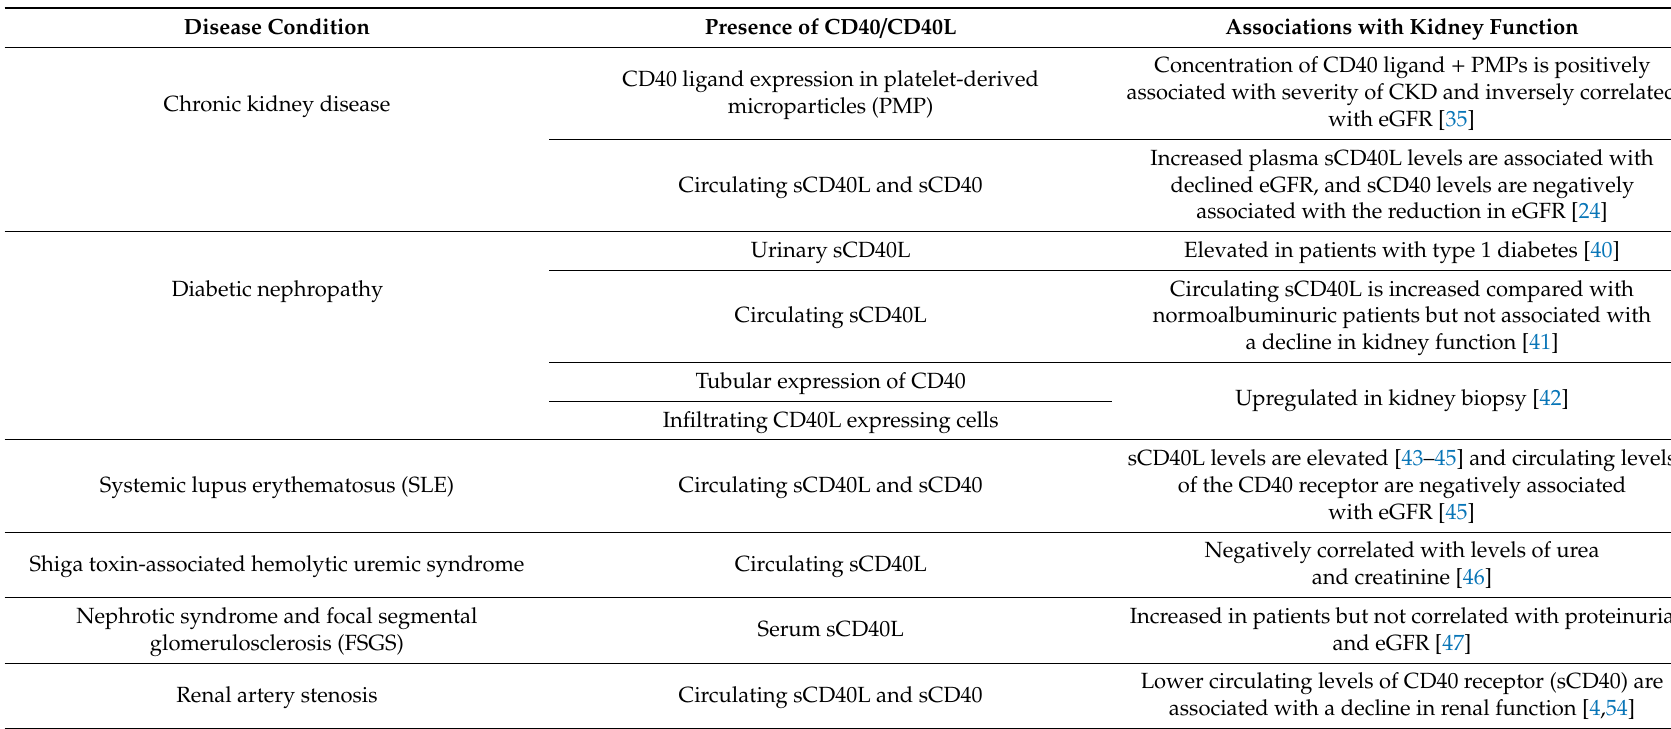
Table 1. Summary of clinical studies demonstrating the associations between CD40 / CD40L and kidney